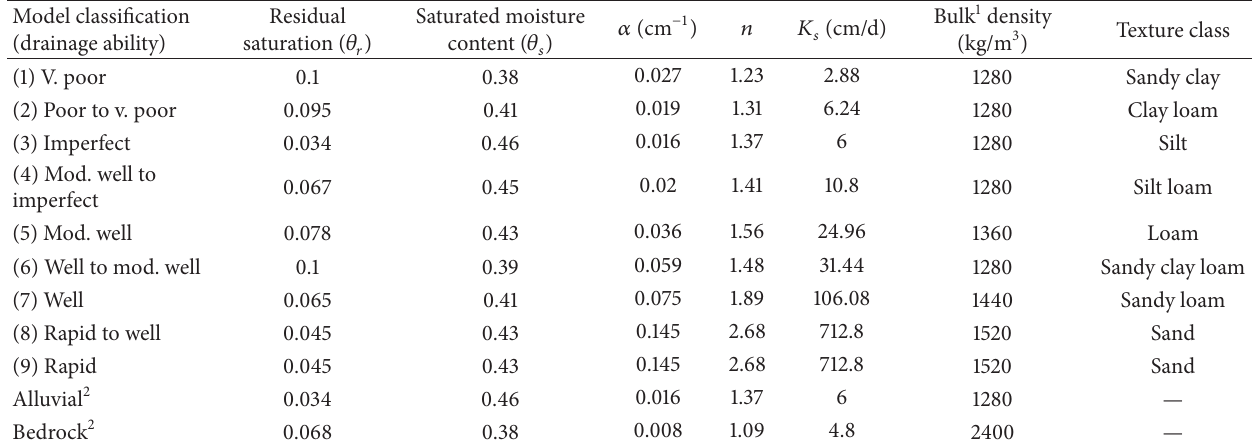
Table 2: van Genuchten parameters for unsaturated zone materials.